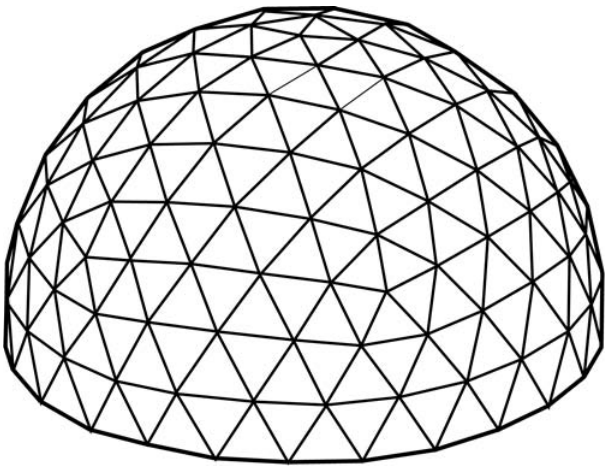
Figure 2. Geodesic dome